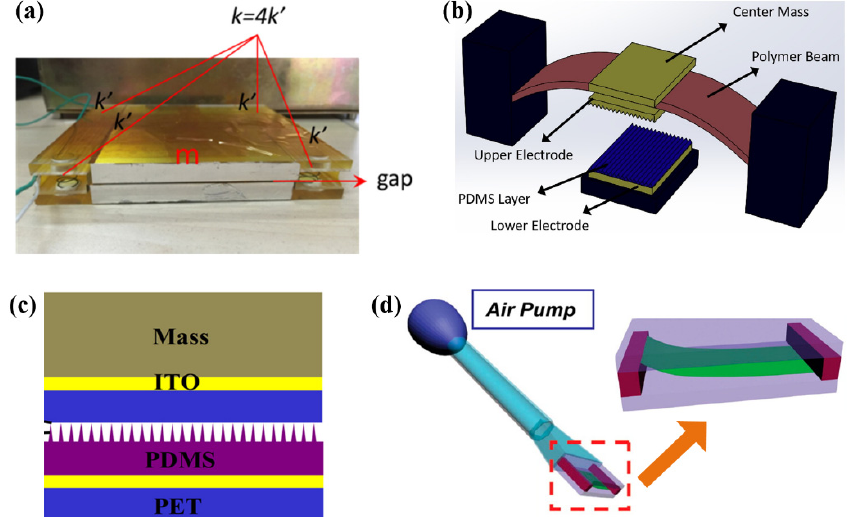
Figure 1. Structures of contact mode TENGs: ( a ) Spring-supported TENG (Reproduced with per- mission [20]. Copyright 2017 Elsevier); ( b ) An elastic beam-based TENG with two steady states (Reproduced with permission [41]. Copyright 2018 Elsevier); ( c ) A TENG with micro-pyramids on tribo-pair (Reproduced with permission [30]. Copyright 2016 Elsevier); ( d ) A TENG with flexible PTFE film (Reproduced with permission [43]. Copyright 2014 American Chemical Society).